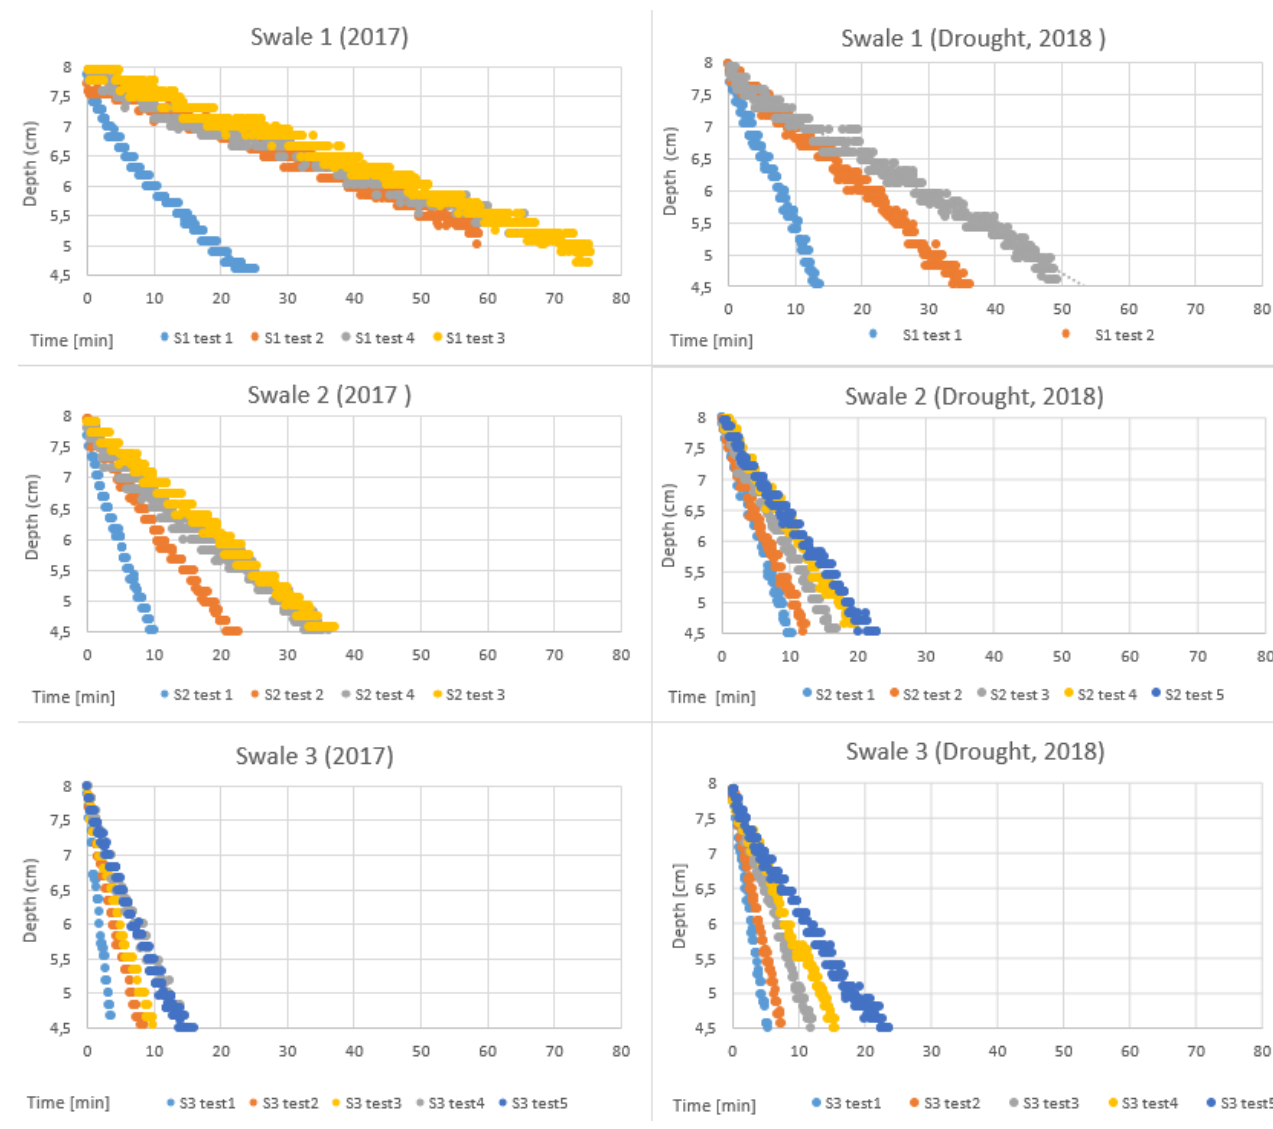
Figure 9. Emptying time graphs of swale 1, 2 and 3 under regular (2017, left ) and drought conditions (2018, right ).